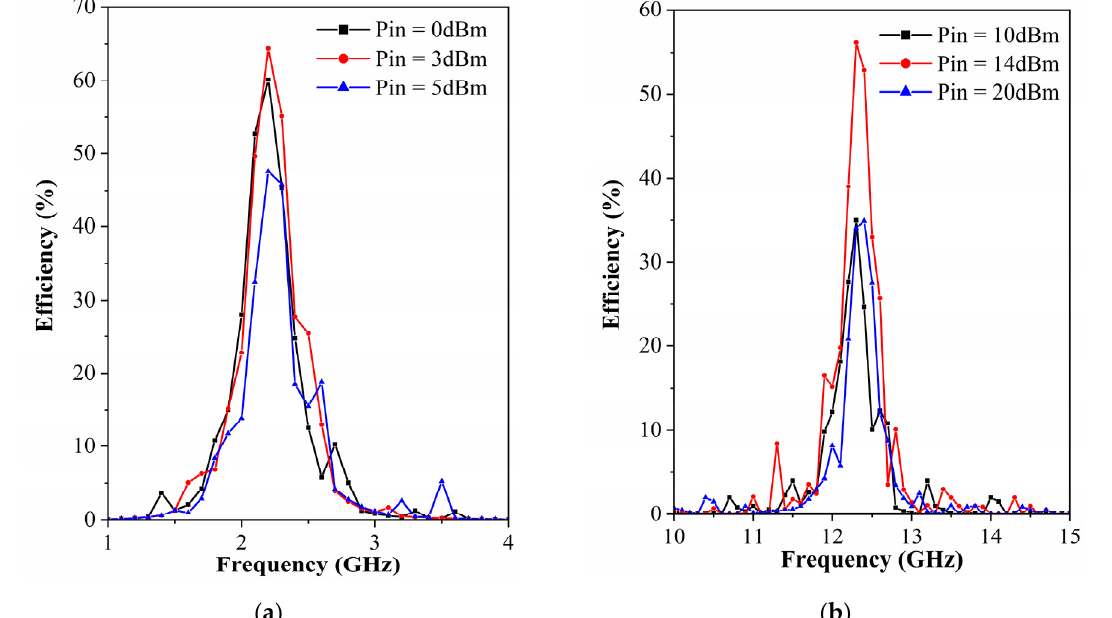
Figure 13. Measured RF-to-dc efficiency of the proposed metasurface array as a function of frequency with ( a ) the single series diode rectifier and ( b ) the voltage doubler rectifier.